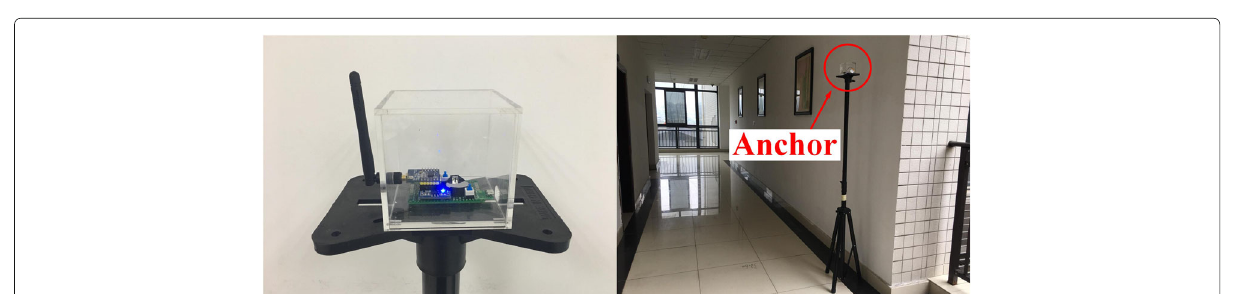
Fig. 19 Photos of the actual